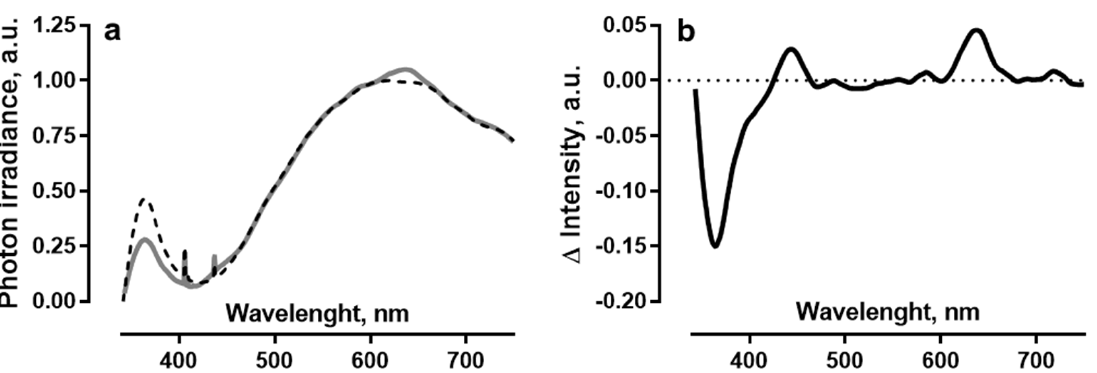
Figure 1. ( a ) Normalized photoluminescence spectrum of a fluoropolymer film containing fluorophores and gold nanoparticles (solid line) and without photoconverting components (dotted line); ( b ) the difference between the intensities of the spectra of a fluoropolymer photoconversion film and a fluoropolymer equalizing filter.